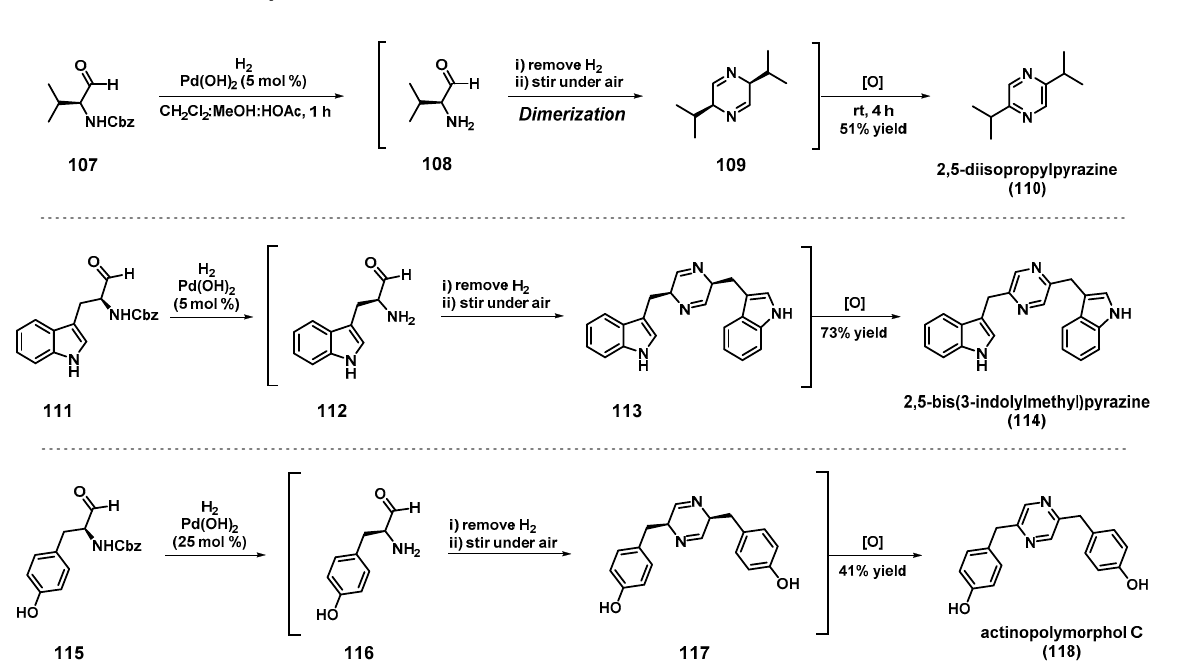
Molecules 2022 , 27 , x FOR PEER Scheme 10. Biomimetically inspired synthesis of 2,5-disubstituted pyrazine alkaloids.